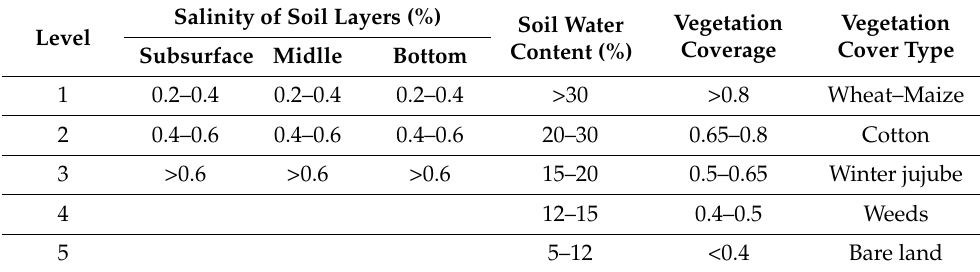
Table 1. Classification of driving factors of soil